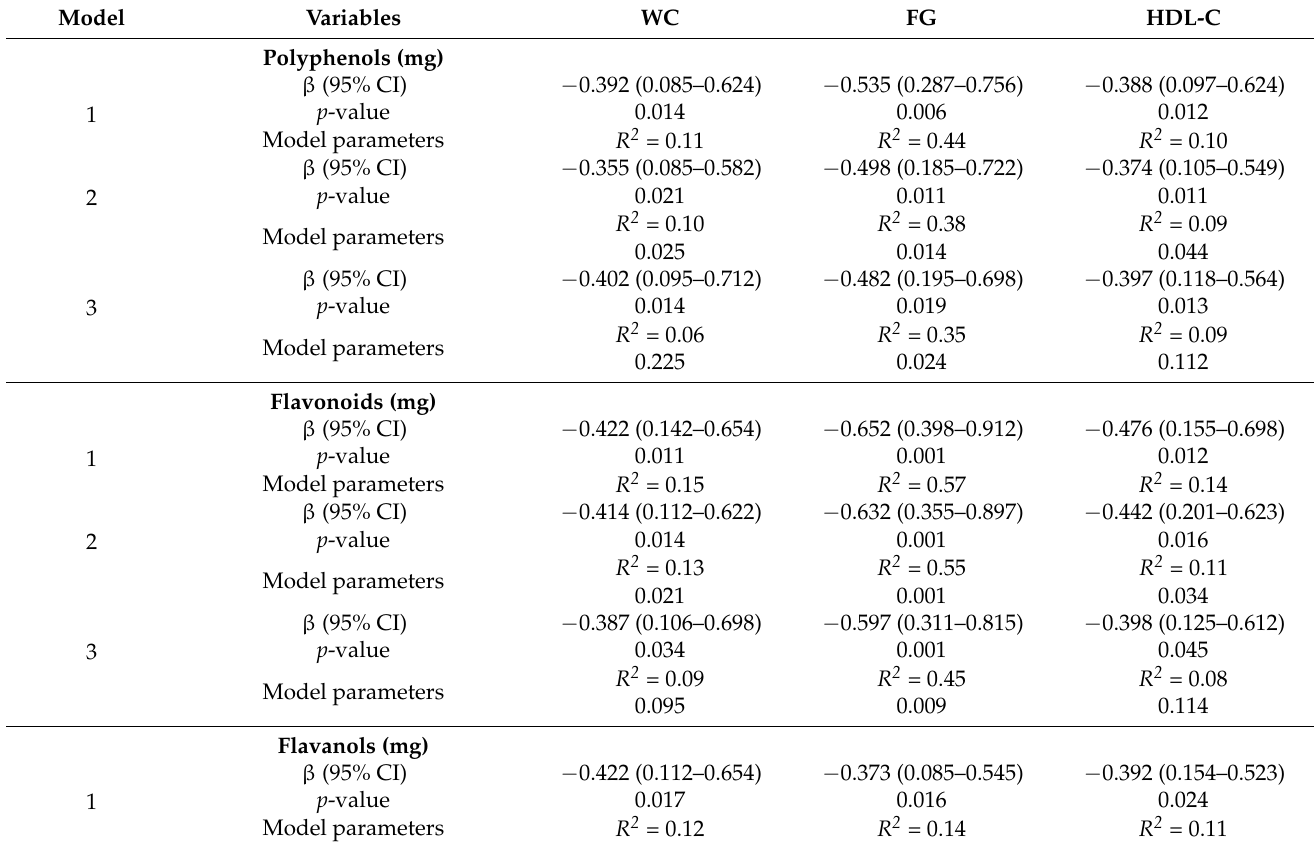
Table 7. Univariate and multivariate linear regression models between dietary polyphenols and MetS risk factors post- intervention in the